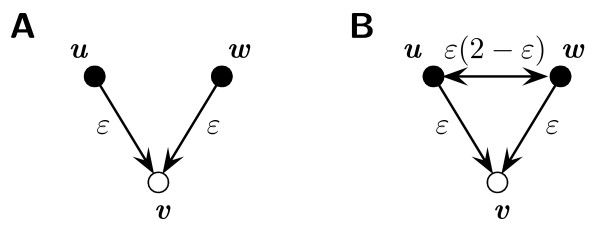
Effect of sampling on preys. This Figure illustrates the probabilities for selecting edges in the limited sampling step if the node v considered is a prey. Here, baits are indicated by black nodes and preys by white notes. The arrows at the end of edges indicate the bait and prey relationship for this edge and edges are directed from bait to prey. Accordingly, edges between baits show arrows at both ends.